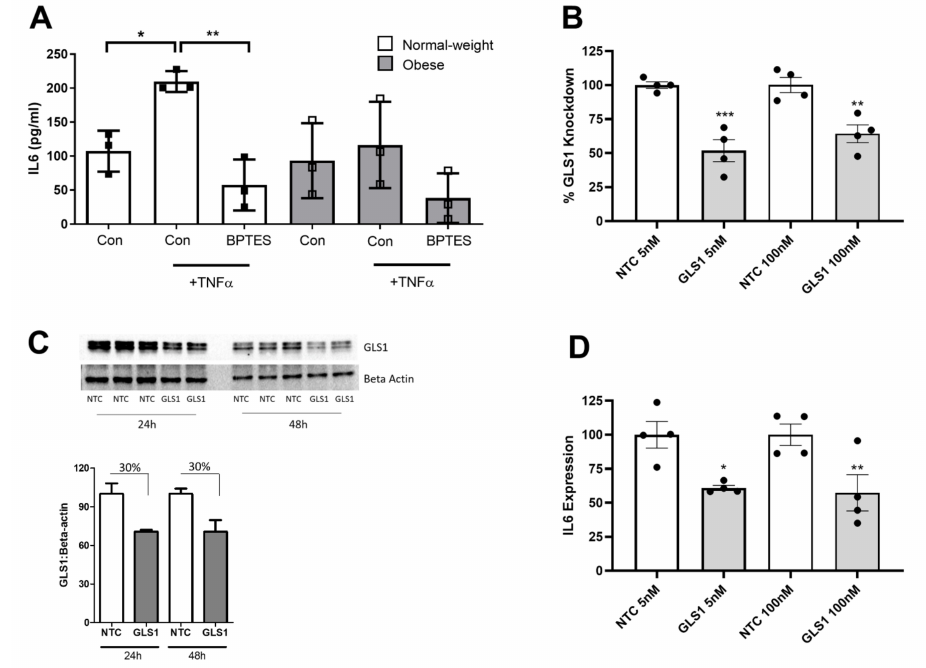
Figure 5. Inhibition of glutaminase-1 attenuates the IL-6 inflammatory response in OA synovial fibroblasts. ( A ) GLS1 inhibitor, BPTES (20 µ M), attenuates TNF α induced IL-6 secretion in synovial fibroblasts from normal weight and obese hip OA patients (n = 3 patients). Bars represent mean IL-6 secretion (pg/mL). ( B ) % knockdown of GLS1 expression in OA synovial fibroblasts after 24 h post-transfection with a GLS1 targeting siRNA (5 nM or 100 nM), compared to a non-targeting control (NTC) siRNA (n = 4 patients). ( C ) Confirmation of siRNA-mediated GLS1 protein knockdown at 24 h and 48 h post-transfection using 100 nM siRNA. ( D ) Effect of sRNA-mediated knockdown of GLS1 on IL-6 expression in OA synovial fibroblasts at 24 h post-transfection (n = 4 patients). Data are presented as mean ± SEM. * = p < 0.05, ** = p < 0.01, *** = p <